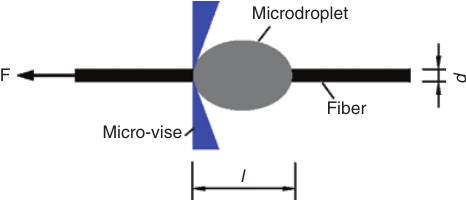
Figure 1: Sketch of the microbond pull-out test.